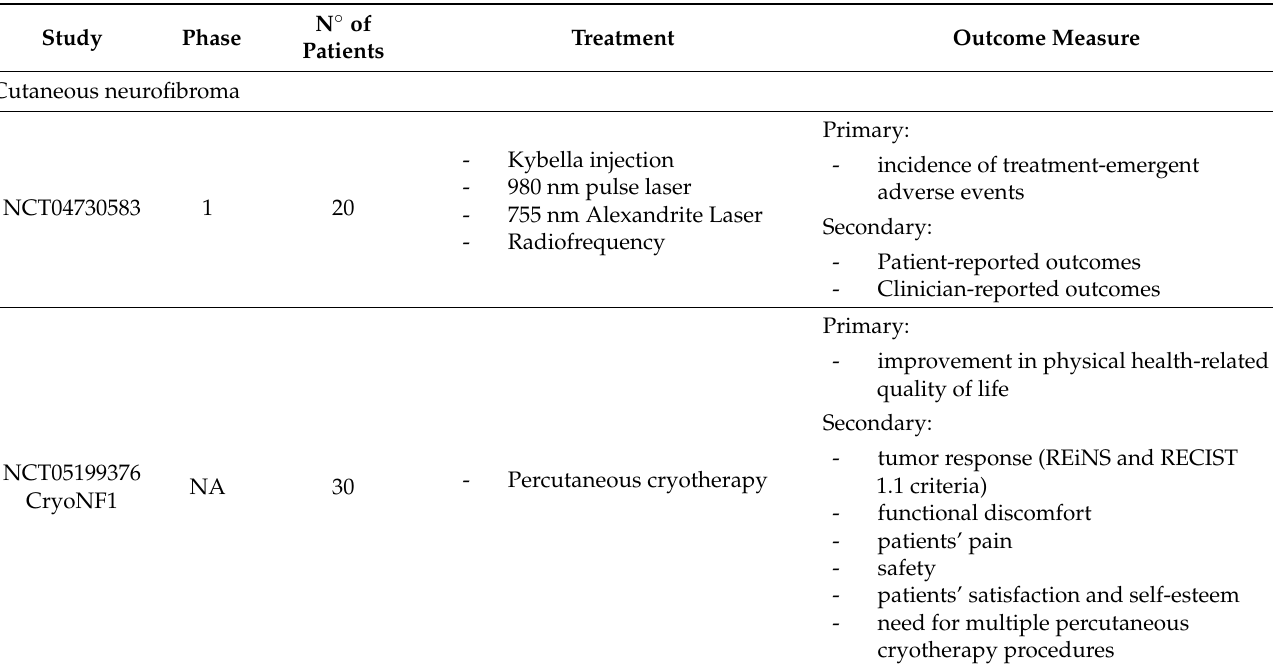
Table 5. Medical treatments: ongoing clinical